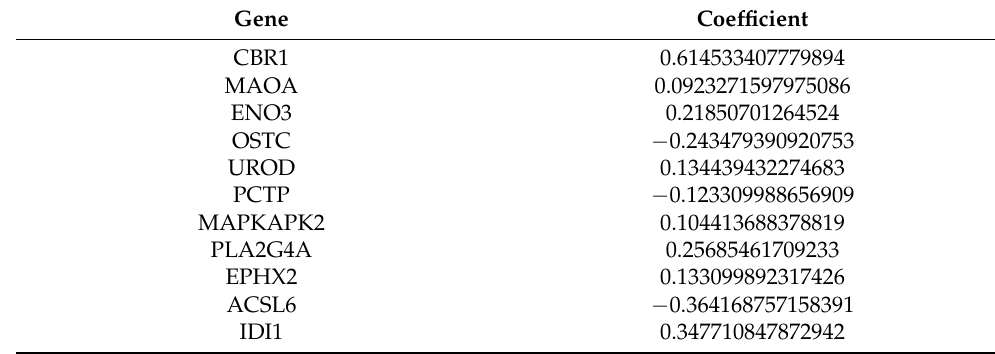
Table 1. Eleven fatty acid metabolism-related genes detected using LASSO regression analysis. Gene